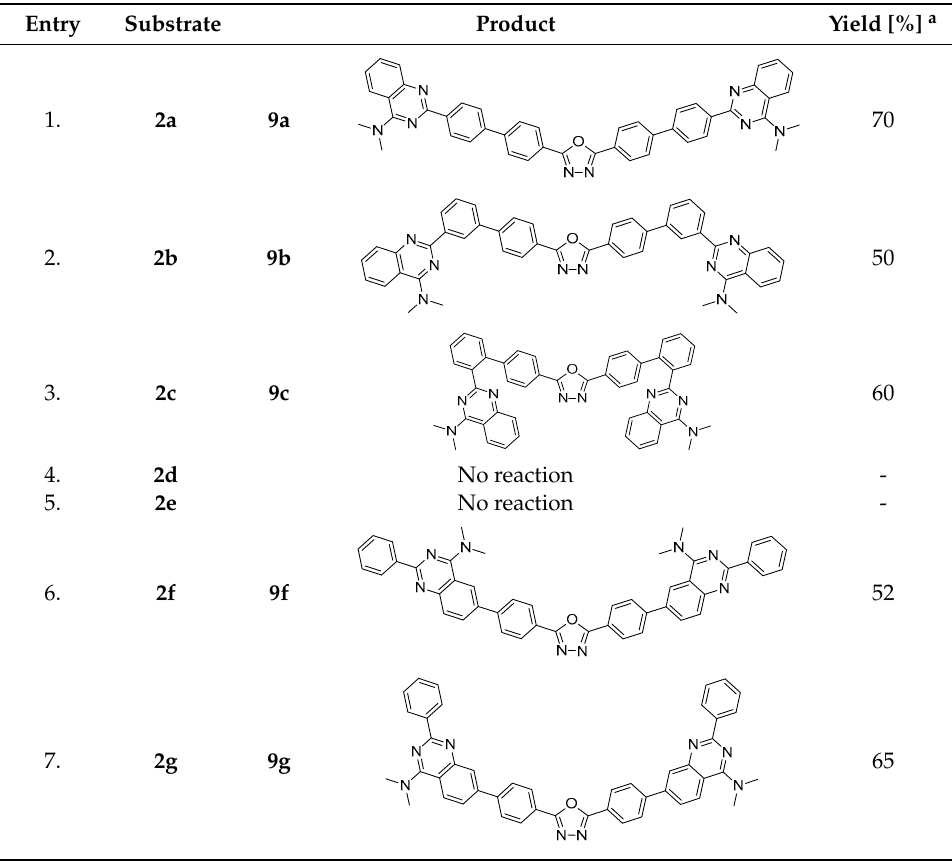
Table 3. Synthesis of symmetrical 2,5-bis(quinazolinylphenyl)-1,3,4-oxadiazole derivatives ( 9a-c , 9f-g ) using Suzuki cross-coupling reactions.